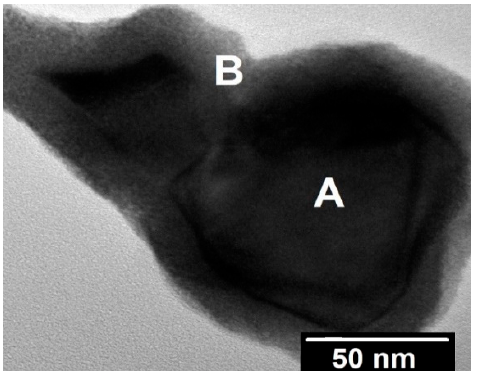
Figure 6. Bright-field TEM image with the difference in colors pointing to the presence of unreacted UO 2 (A) surrounded by UC 2 − y (B).